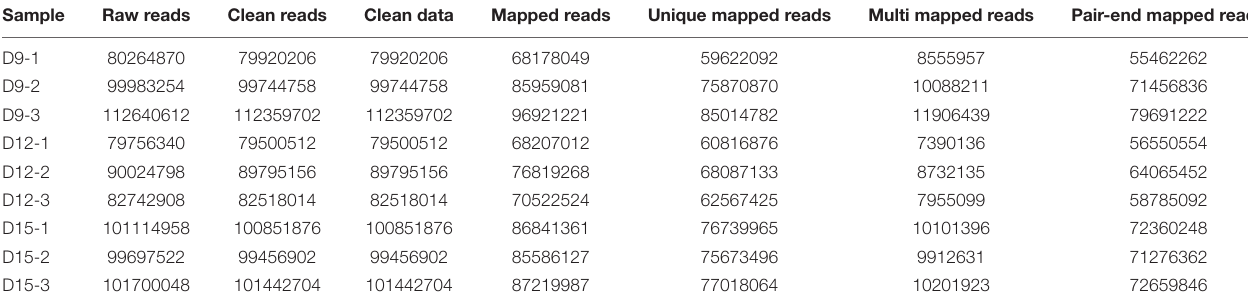
TABLE 1 | Summary of RNA-Seq